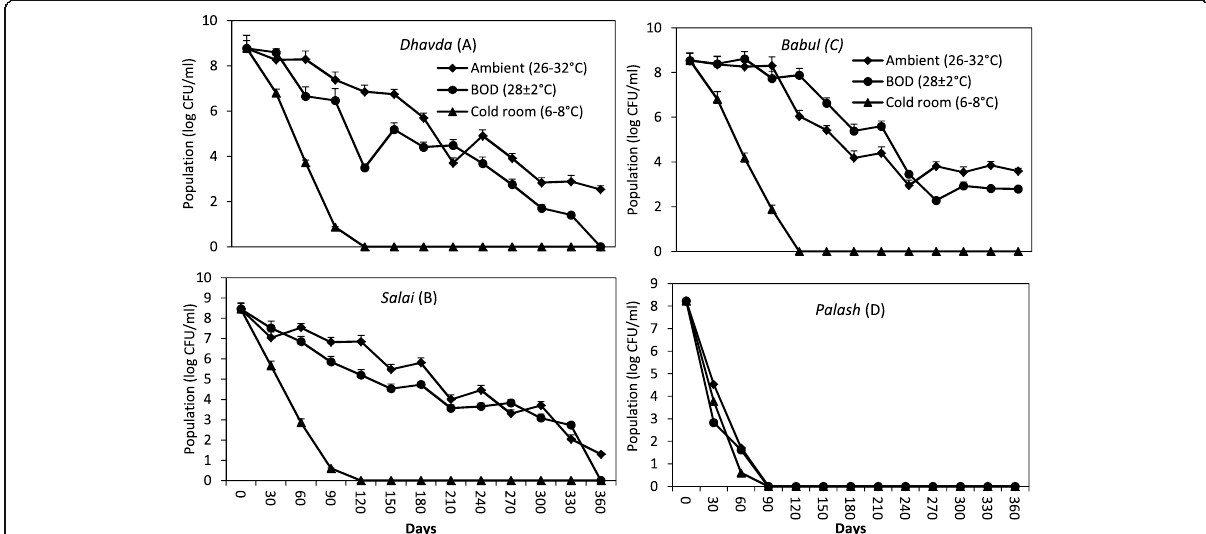
Fig. 4 Population dynamics of Chromobacterium violaceum strain TRFM-24 in four different natural plant gums a Dhavda , LSD ( P = 0.05 ) 0.88; b Salai , LSD ( P = 0.05 ) 0.69; c Babul , LSD ( P = 0.05 ) 0.83; d Palash , LSD ( P = 0.05 ) 0.67 under various temperature regimes (ambient temperature (26 – 32 °C), BOD incubator (28 ± 2 °C) and cold room (6 – 8 °C) conditions; LSD , least significant difference ( P = 0.05 ); data are mean of three replications; error bars are the standard deviation of means